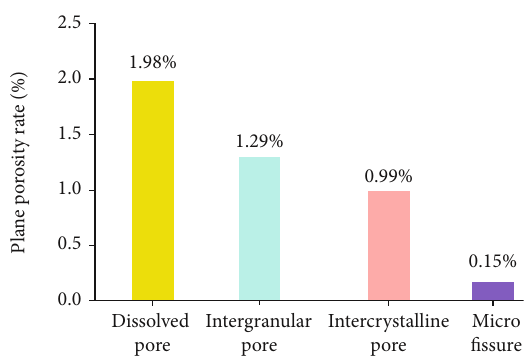
Figure 1: Proportion of three types of rock in He8. Figure